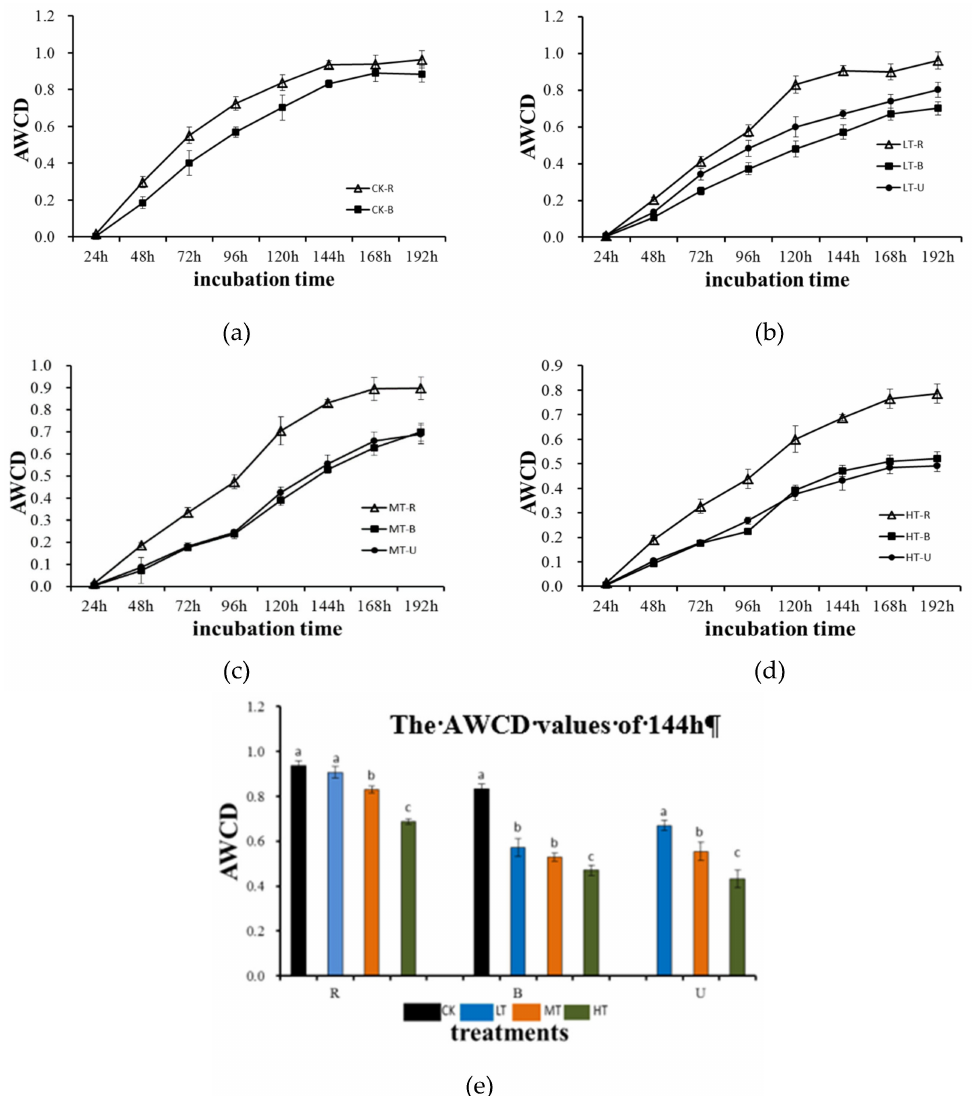
Figure 4. Microbial community metabolic activity (AWCD) of CK ( a ), 500mg/kg treatment ( b ), 1000mg/kg treatment ( c ), 1500mg/kg treatment ( d ) and the AWCD values of 144h ( e ). CK, 0 mg/kg; LT, 500 mg/kg; MT, 1000 mg/kg; HT, 1500 mg/kg; R, rhizospheric soil; B, bulk soil; U, unplanted soil. Different letters indicate that values differ significantly at p < 0.05. Values represent mean ± SD ( n =